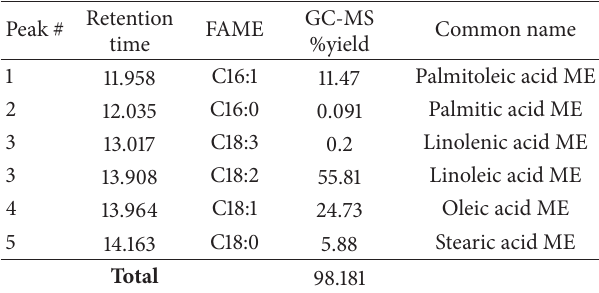
Table 3: Composition of fatty acid methyl esters (FAME) for the optimum produced